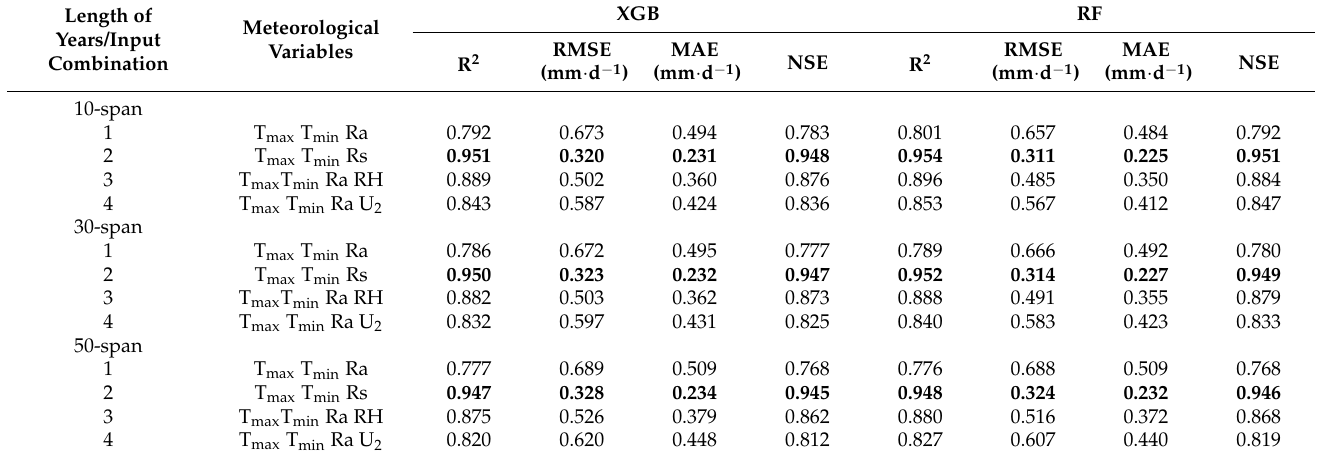
Table 3. Average statistical values of different input parameters of two machine learning models in the testing stages of 21 stations from various time lengths of input